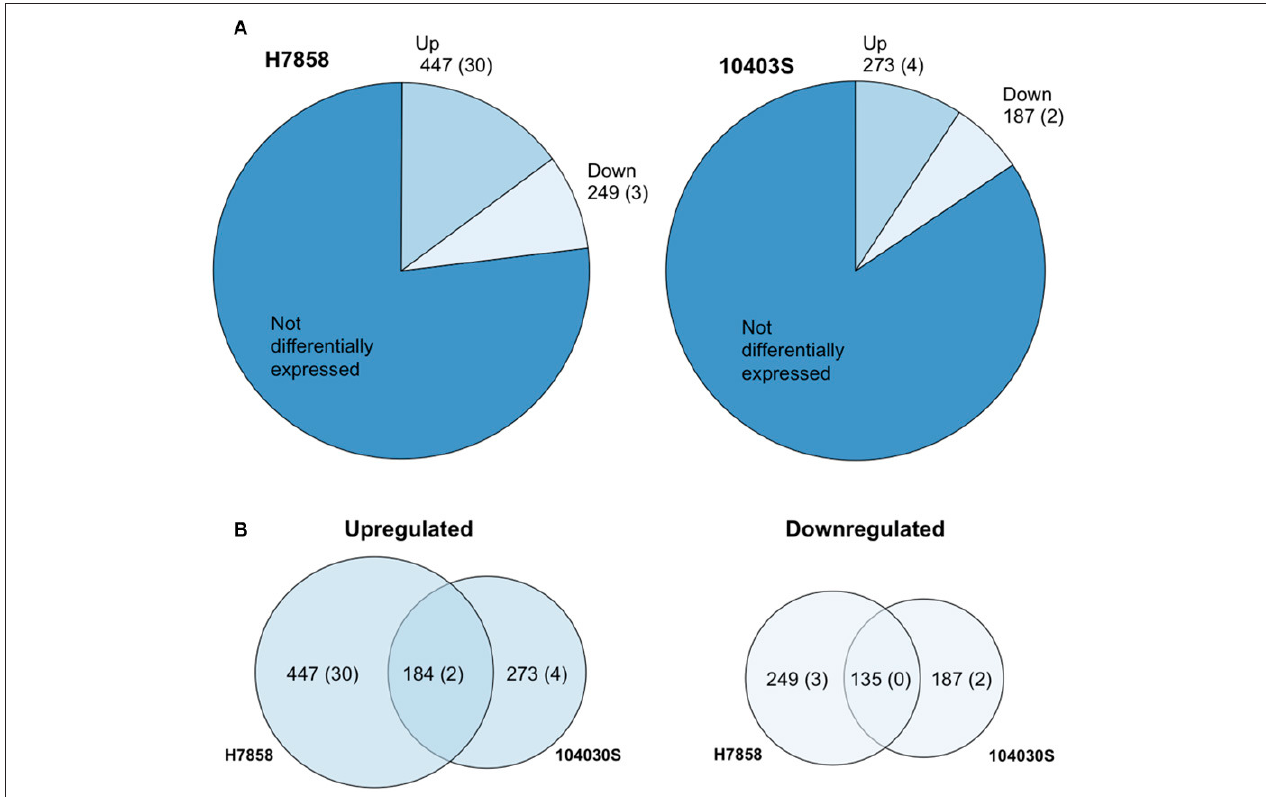
FIGURE 1 | The Bile Stimulon. (A) Pie charts showing the number of L. monocytogenes total transcripts found to be affected by exposure to bile at pH 5.5 in strains H7858 and 10403S, with number of ncRNAs in parenthesis. H7858 and 10403S genomes include, respectively, a total of 3029 and 2956 annotated genes and ncRNAs. (B) Proportional Venn diagram showing the overlap of transcripts with significantly higher (Upregulated) or lower (Downregulated) levels after exposure to bile in H7858 (left) and 10403S (right), with number of non-coding RNAs in